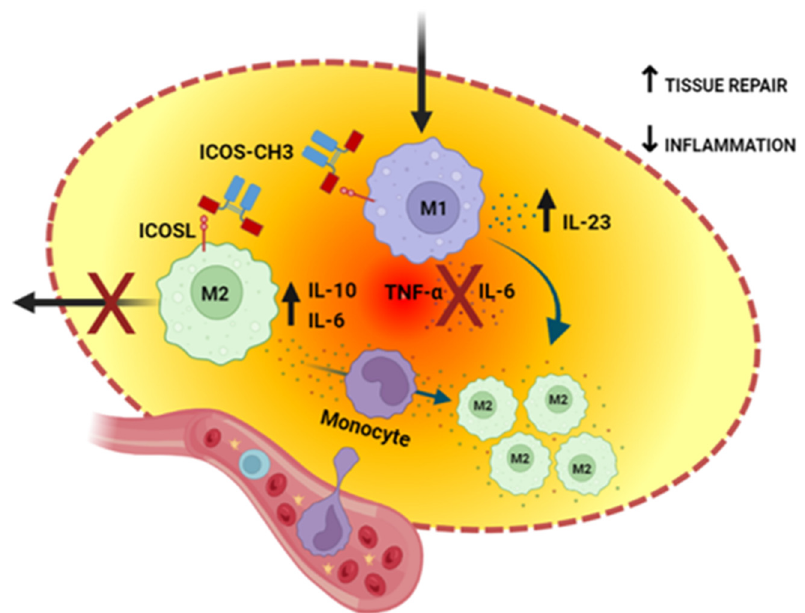
Figure 7. Graphical representation of the ICOS-CH3 differential effects of M1 and M2 cells in the setting of acute tissue damage. ICOS-CH3 inhibits the secretion of TNF- α and IL-6 in M1 cells while promoting IL-10 secretion in M2 macrophages. Moreover, it balances IL-6 secretion, increases in M2 cells and decreases in M1 cells. The ICOS-CH3 effect on cell migration would increase the recruitment of M1 cells, which may be reprogrammed to M2 cells by the surrounding anti- inflammatory environment while retaining M2 cells. The net result would be enhanced tissue repair and decreased inflammation. Created with BioRender.com.